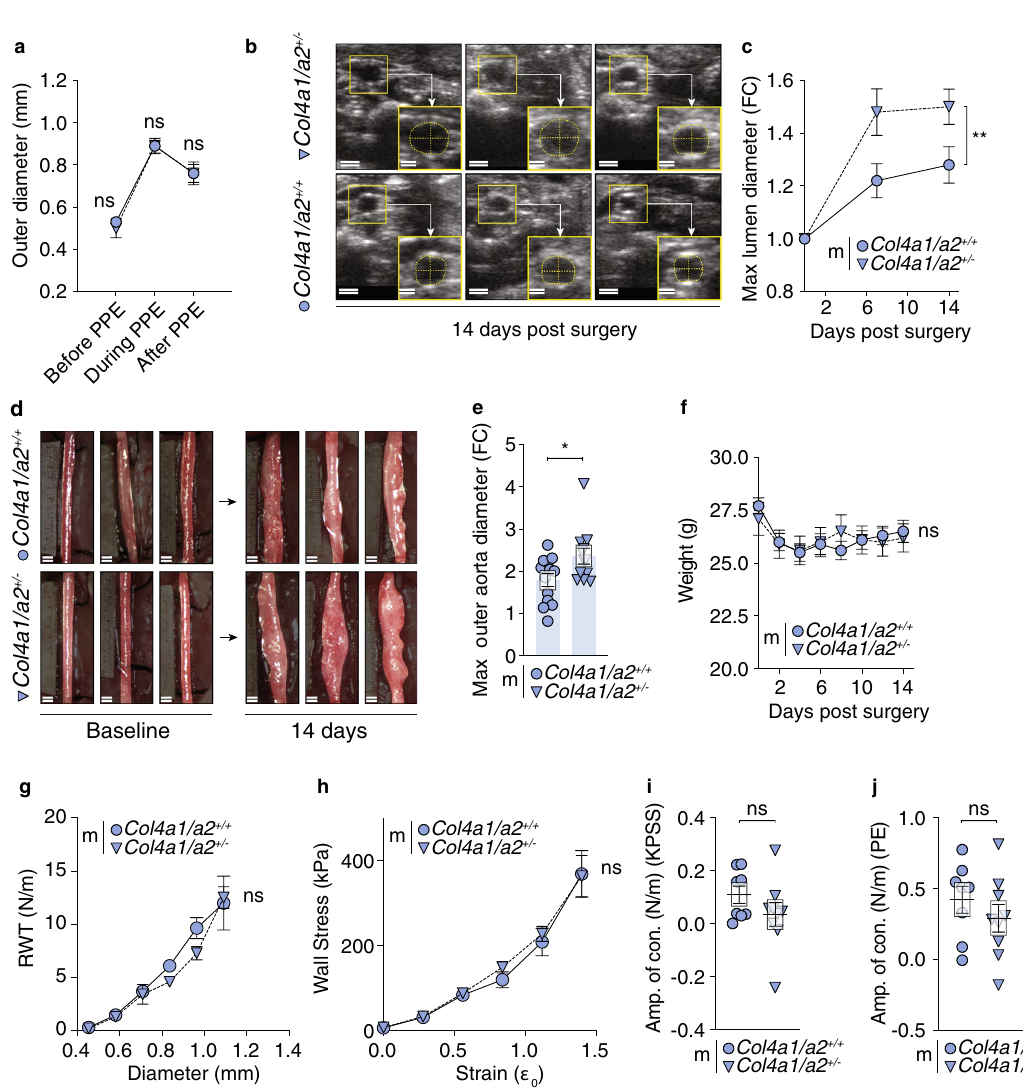
Fig. 2c), a measure proportional to Youngs modulus of the arterial wall, were not affected by genotype. Further- more, the wire myography data indicate that the function of VSMCs under these experimental conditions were